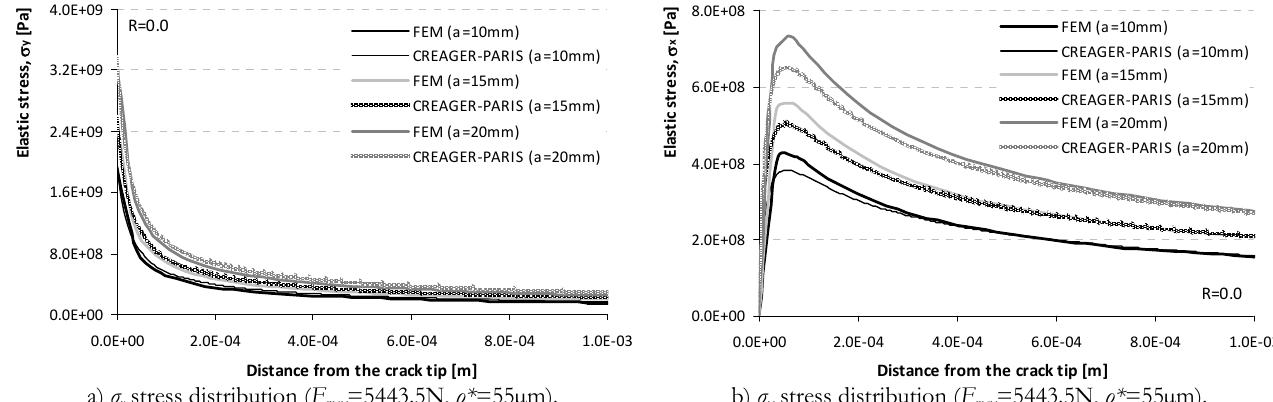
Figure 11: Elastic stress distribution ahead of the crack tip and along the crack plane line (y=0) for CT specimens made of the S355 steel: comparison between analytical and numerical results. Distinct crack sizes considered.